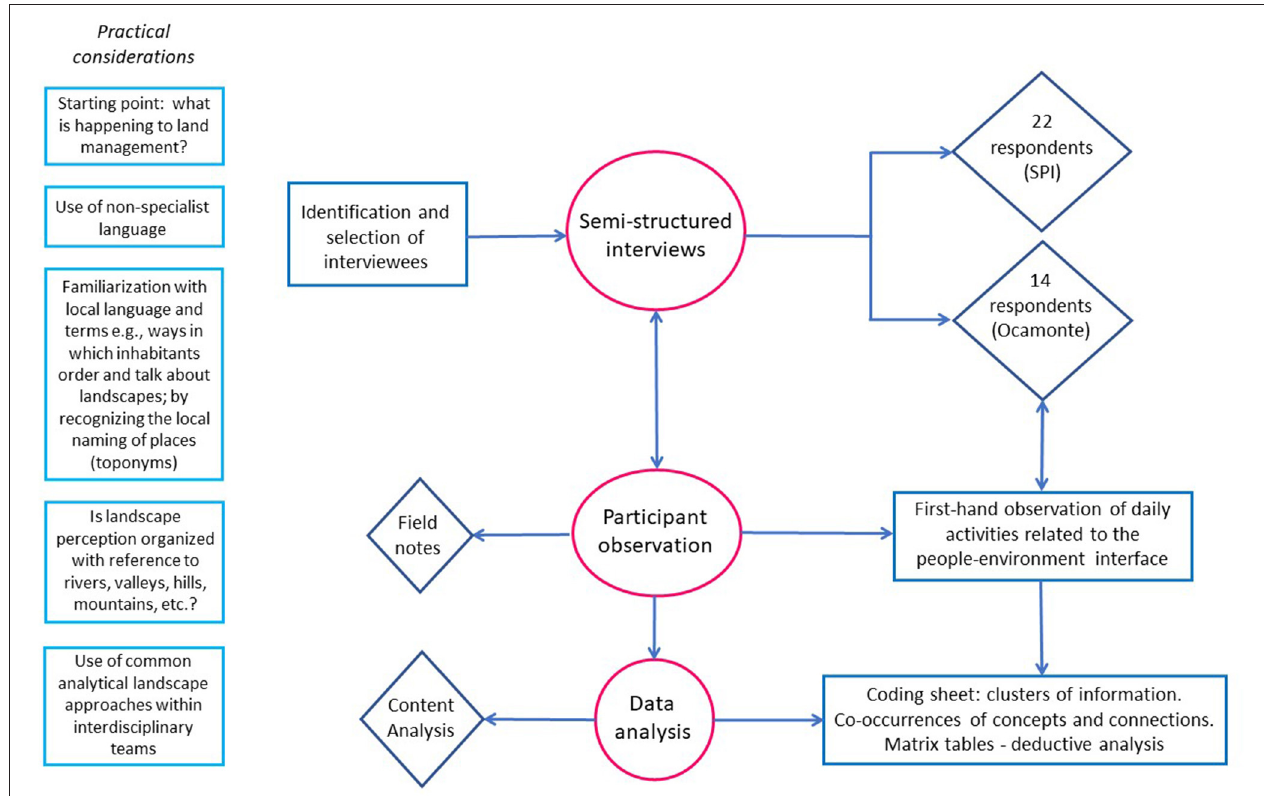
FIGURE 1 | Ethnographic methods and the way of collecting and analyzing